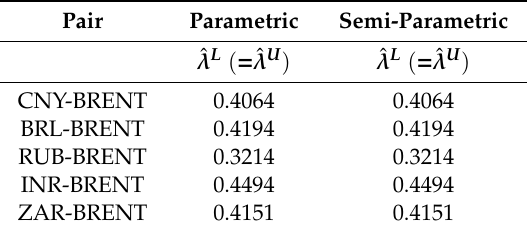
Table A4. Tail dependence coe ffi cients of the Student’s t copula model.